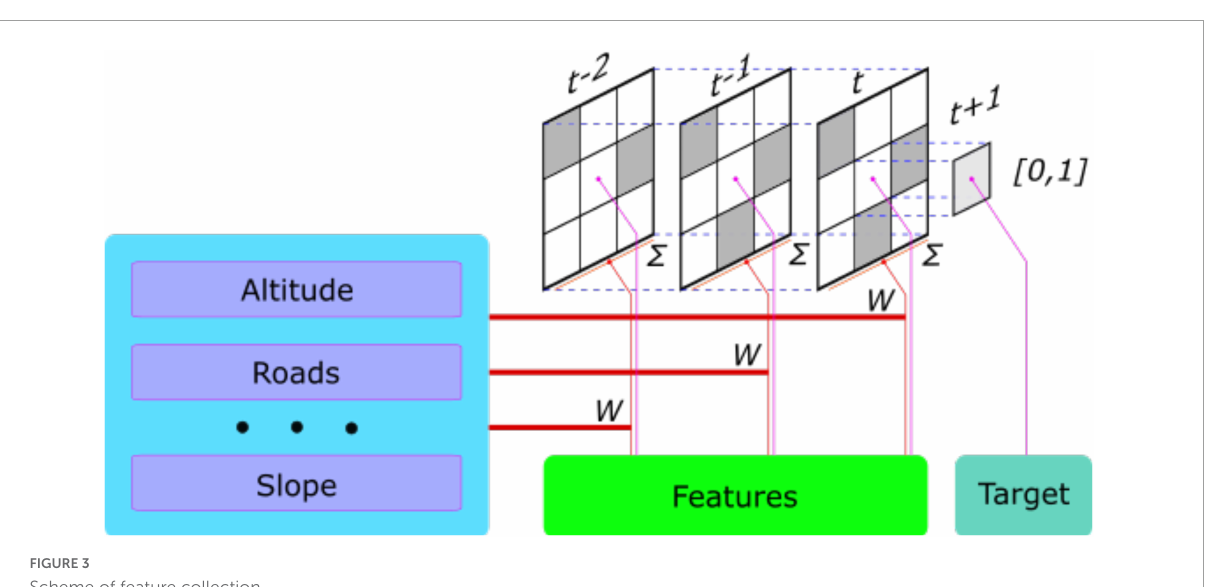
FIGURE3 Scheme of feature